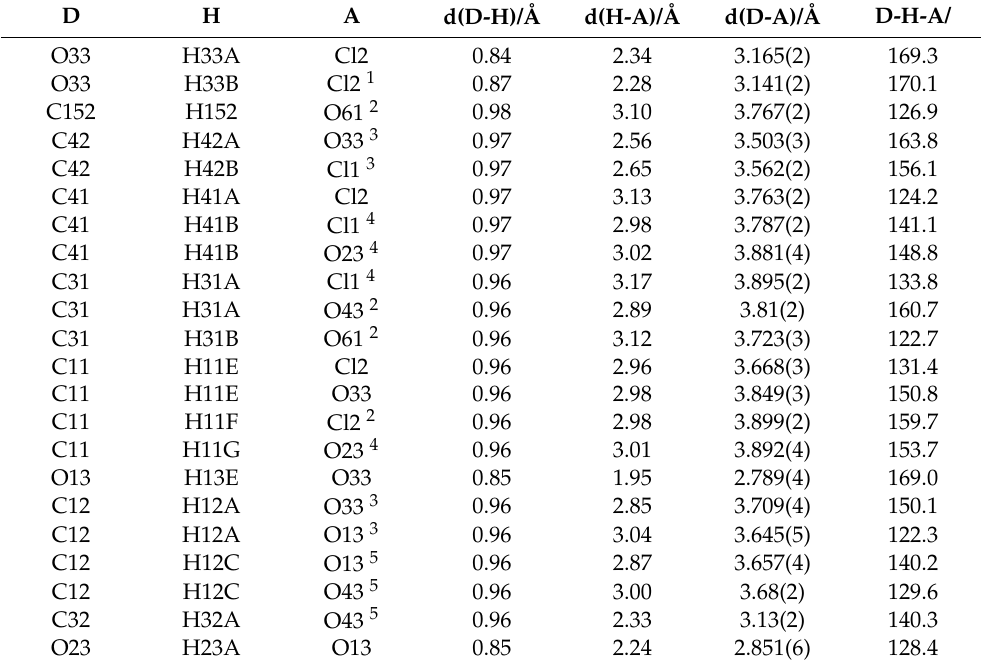
Table 2. Detected hydrogen, halogen, and weak C-H . . . O bonding interaction in the crystal structure of